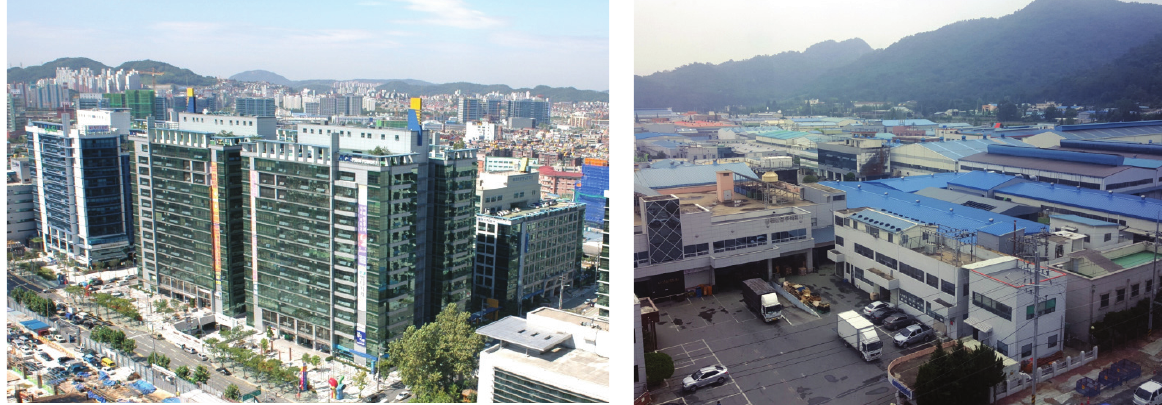
Figure 1. Example of a flatted factory (left) vs. regular factory (right) in Korea (source: